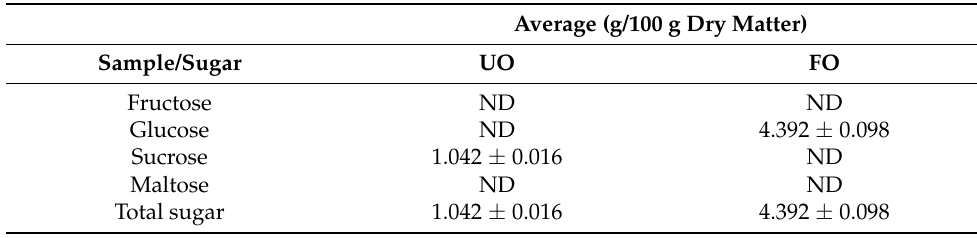
Table 1. Free sugars in okara before and after fermentation. Data represent mean ± SEM of three replicates ( p < 0.05); ND—not detected, i.e., amount of sugar is lower than LOD. Trace means the amount of sugars is higher than LOD, but lower than LOQ.